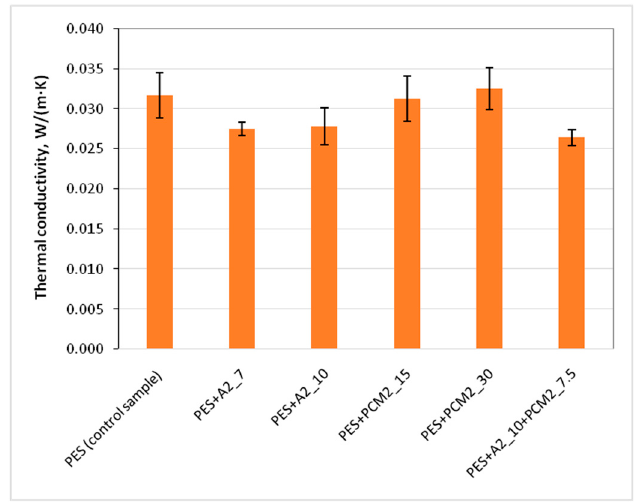
Figure 5. Thermal conductivity of the nonwoven inserts.